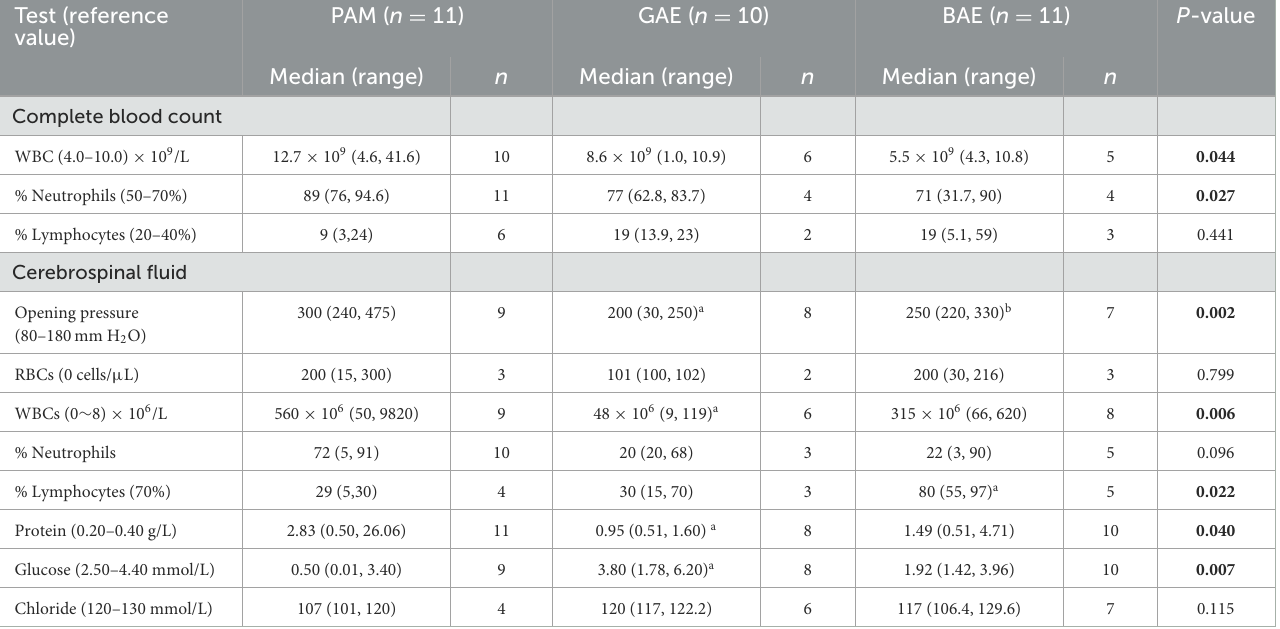
TABLE 3 Initial laboratory findings for three free-living amoebae infections in